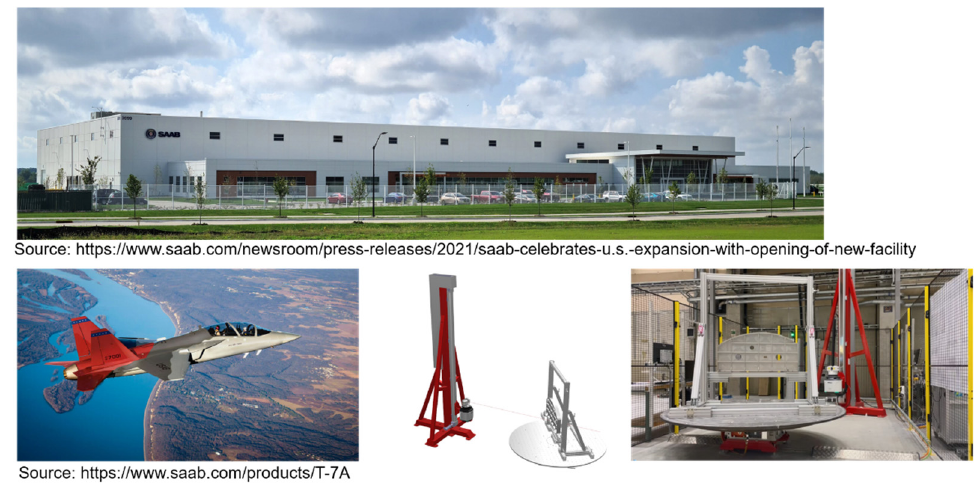
Figure 1. The new Saab Inc “greenfield” factory. The new eT7-A, USAF, pilot training aircraft and the experimental automated dimensional metrology system virtually and physically displayed. By the courtesy of Saab AB and Saab Aeronautics.